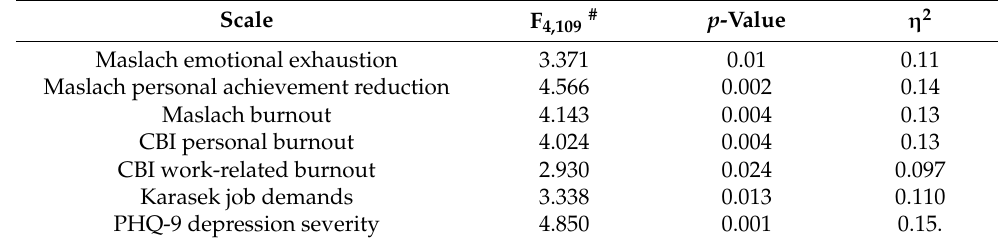
Table 8. Burnout, depression, and occupational stressors subscales comparison regarding total years of work at the present